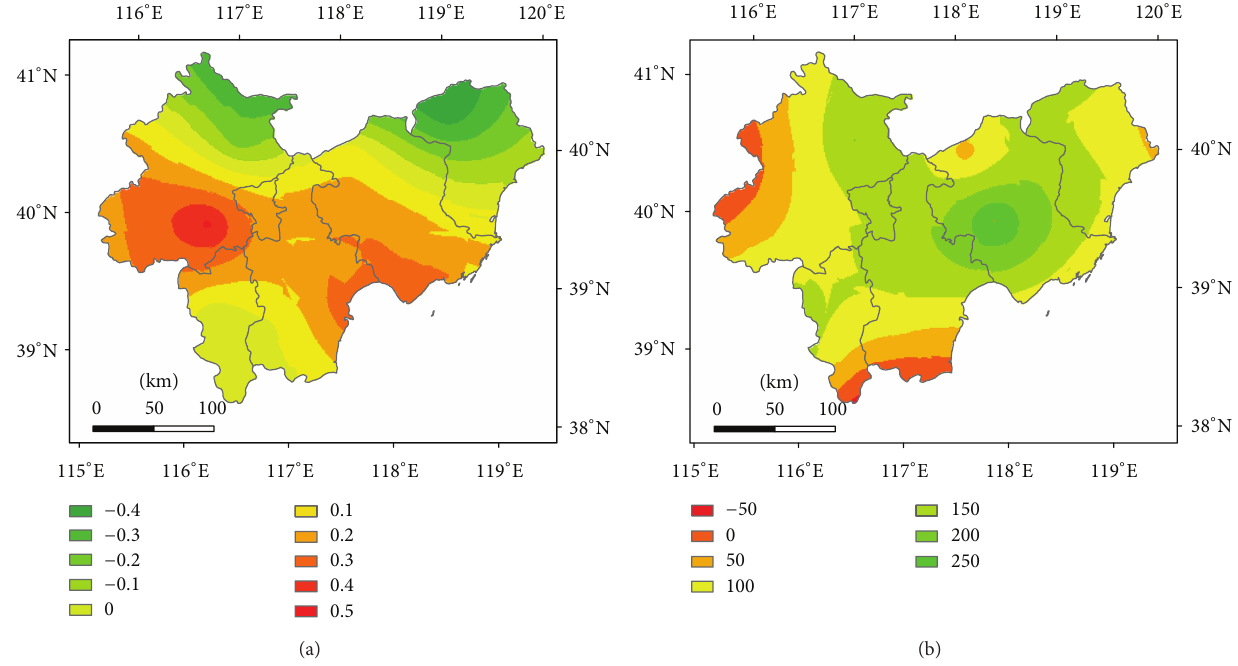
Figure 1: Simulated changes of temperature (a) and precipitation (b) in Beijing-Tianjin-Tangshan Metropolitan area during 1995–2005.